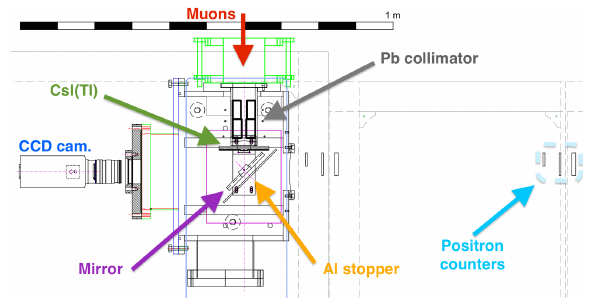
Figure 1. The beam test experimental setup scheme, top view. Figure 2. The view of the beam